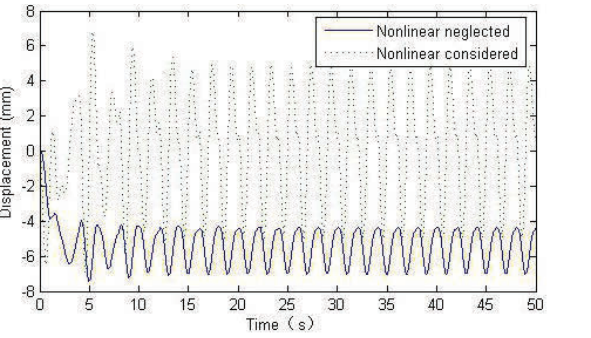
Figure 6. Displacement of mid-span of the bridge under series moving constant